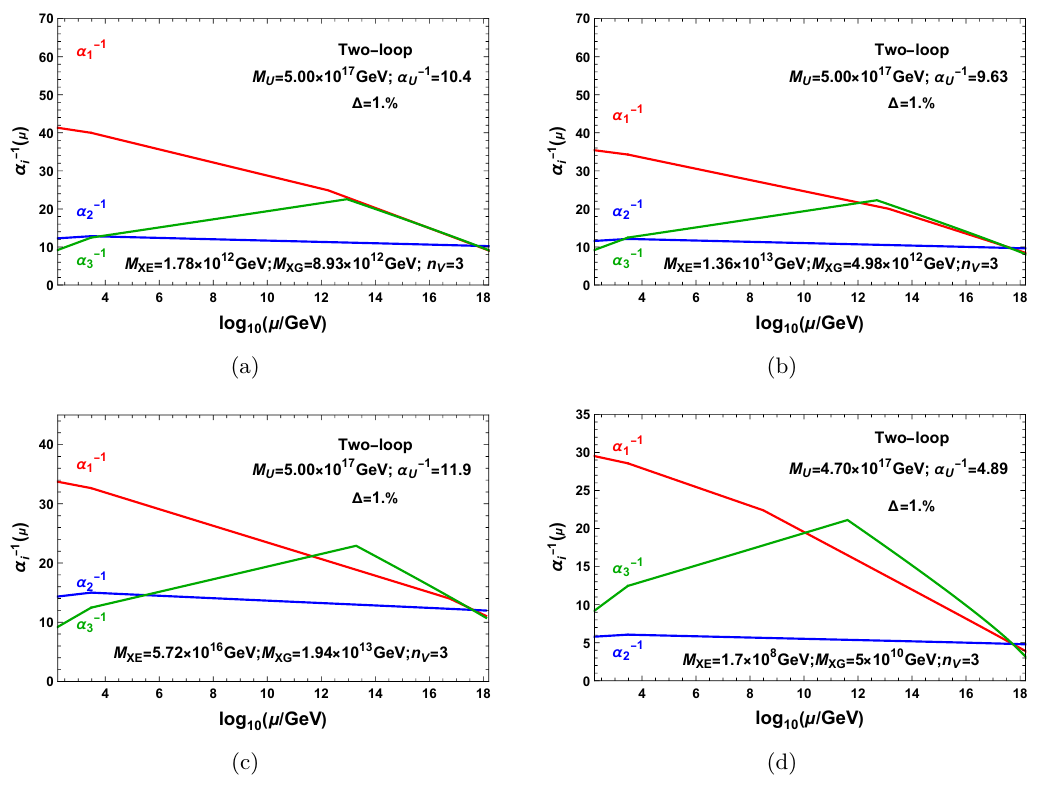
Figure 23 . Two-loop evolution of gauge couplings for the Model 30 (a), Model 31 (b), Model 32 (c) and Model 33 (d) with vector-like particles. The string-scale gauge coupling relation can be achieved by adding 3( XE + XE ) + 3 XG